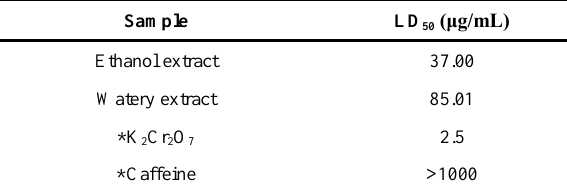
Table 6. 50% Lethal dosage of ethanol and watery extracts of the stem barks of Phyllanthus Albizzioides